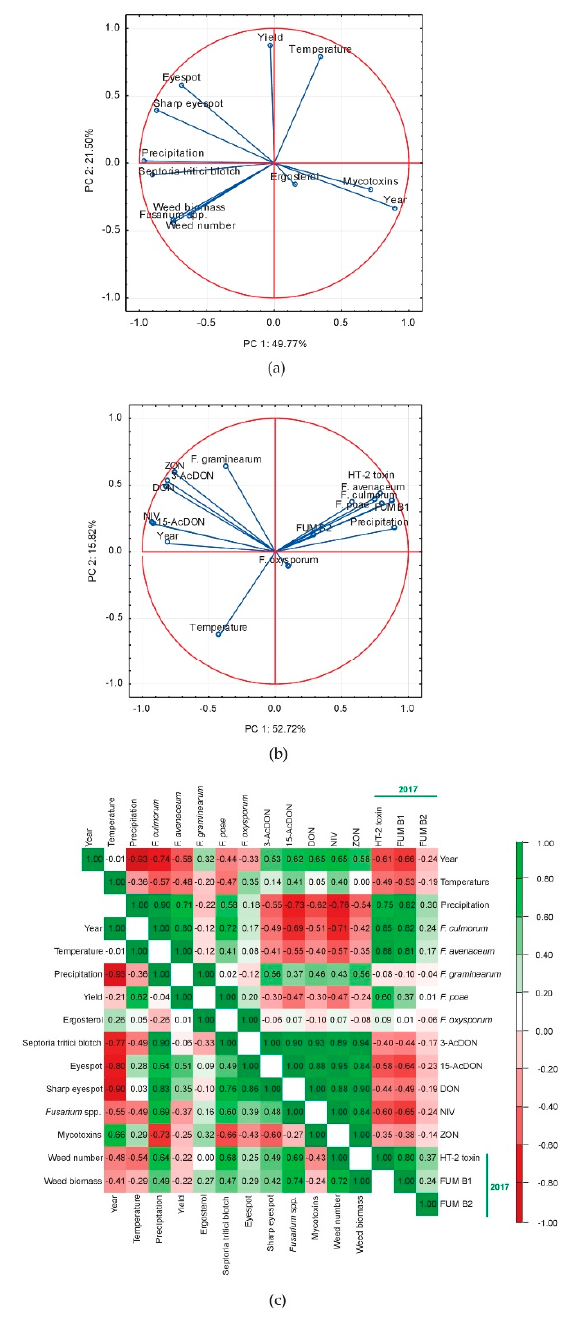
Figure 6. ( a ) Principal component analysis of the chemical and biostimulator treatment impact on the examined wheat grain parameters in 2017–2020. ( b ) Detailed principal component analysis of the chemical and biostimulator treatment impact on the particular Fusarium spp. and mycotoxins occurrence in 2017–2020. ( c ) Heatmap based on Pearson’s correlation coefficients. Mutual correlation between examined parameters in wheat grain in